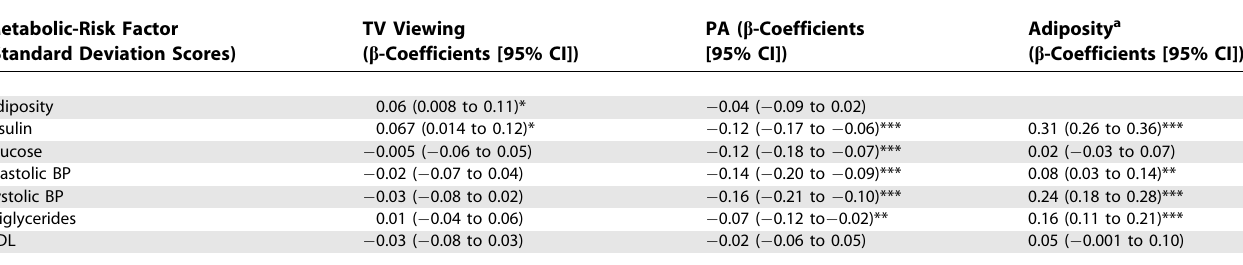
Table 2. Associations of TV Viewing, Objectively Measured PA, and Adiposity with Individual Metabolic-Risk Factors Metabolic-Risk Factor (Standard Deviation